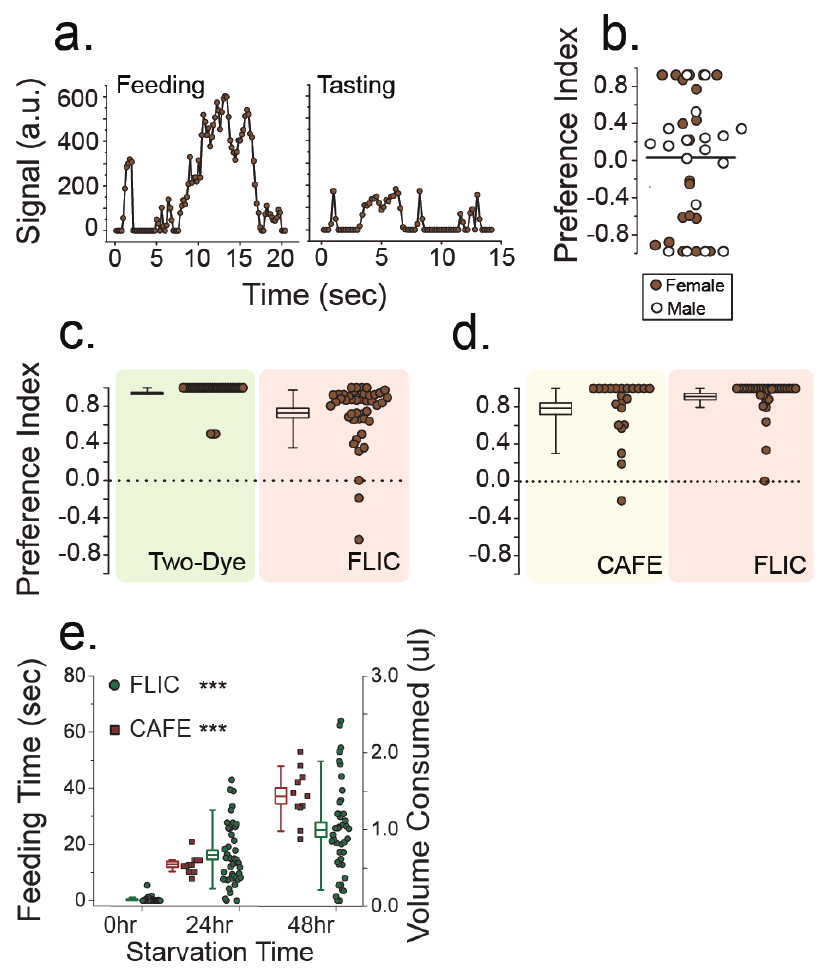
Figure 2. Comparison between traditional food choice assays and the FLIC system. (A) The analog signals from feeding (left) and tasting (right) behaviors have distinct characteristics. (B) When presented with identical food in both food wells, male and female flies do not exhibit a preference, which rules out systematic bias in the FLIC system (open symbol, male; closed symbol, female; pooled paired randomization test, P=0.97). (C) Flies exhibited strong preference in favor of 10% sucrose over 100 m M denatonium when measured using both two-dye and FLIC assays (Box charts represent mean, standard error of mean, and 10–90% quantile whiskers). (D) Flies demonstrated strong preference toward 10% sucrose over 1% sucrose when measured using both the CAFE and FLIC assays (Box charts represent mean, standard error of mean, and 10–90% quantile whiskers). (E) Estimates of food consumption using the CAFE and FLIC assays. Longer starvation resulted in increased food consumption as well as total feeding time (linear regression, P , 1 6 10 2 5 for both assays). Changes in food volume in the capillary tubes was undetectable when fully fed flies were used, and only FLIC data are presented for that treatment. *P # 0.05; **P # 0.01; ***P # 0.001.